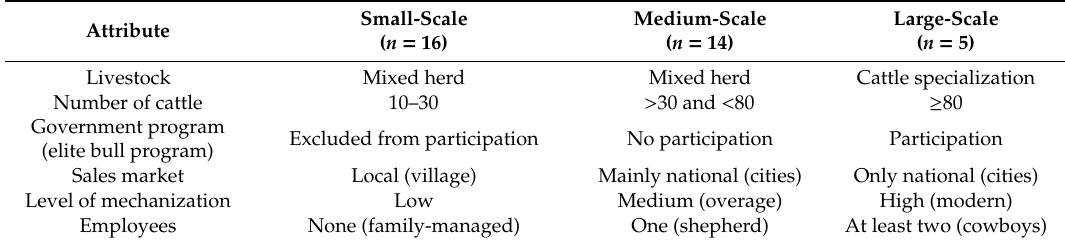
Table 1. Characteristics of three types of individual farms in the Ili Delta